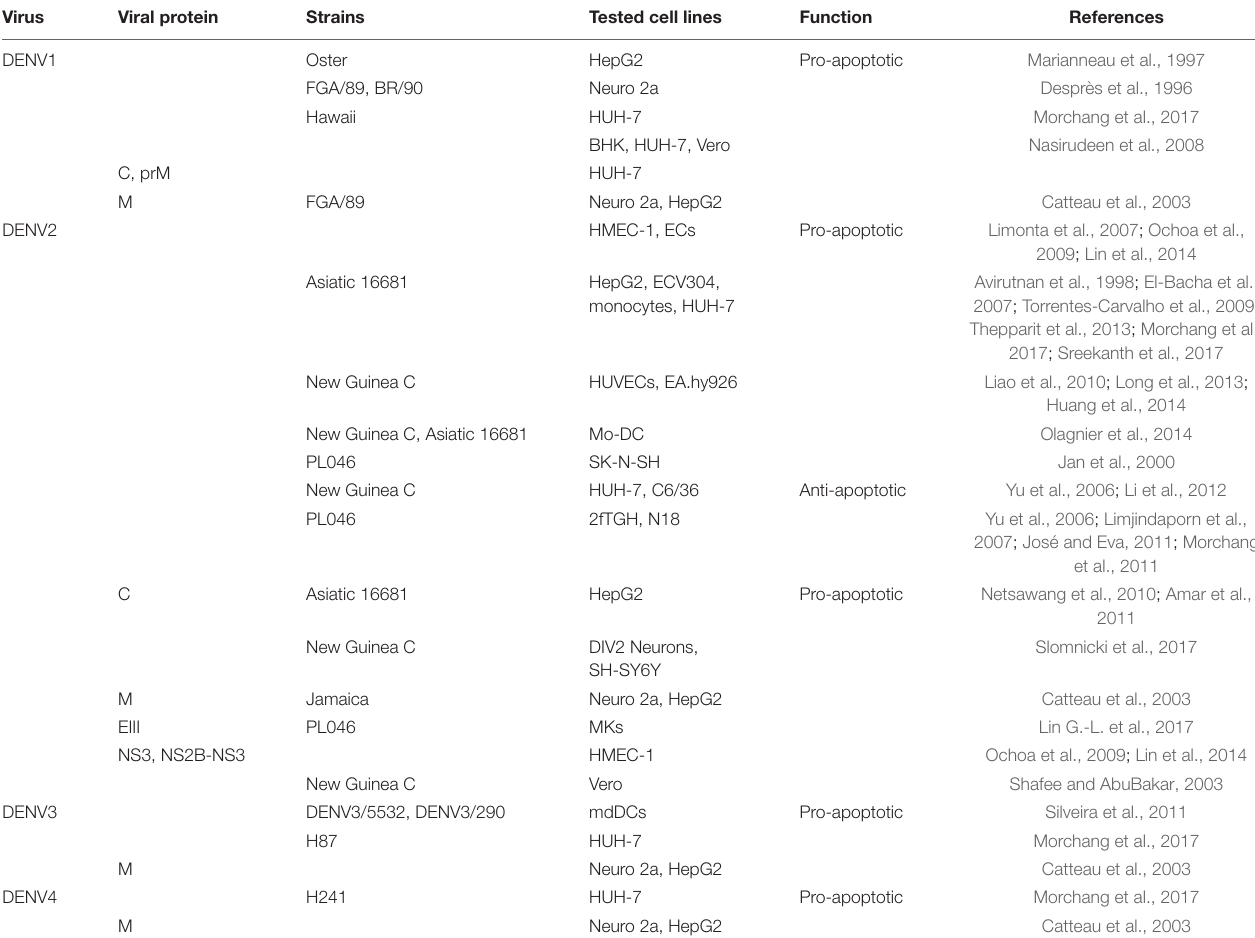
TABLE 1 | Pro-apoptotic or anti-apoptotic activity of DENV and its proteins.